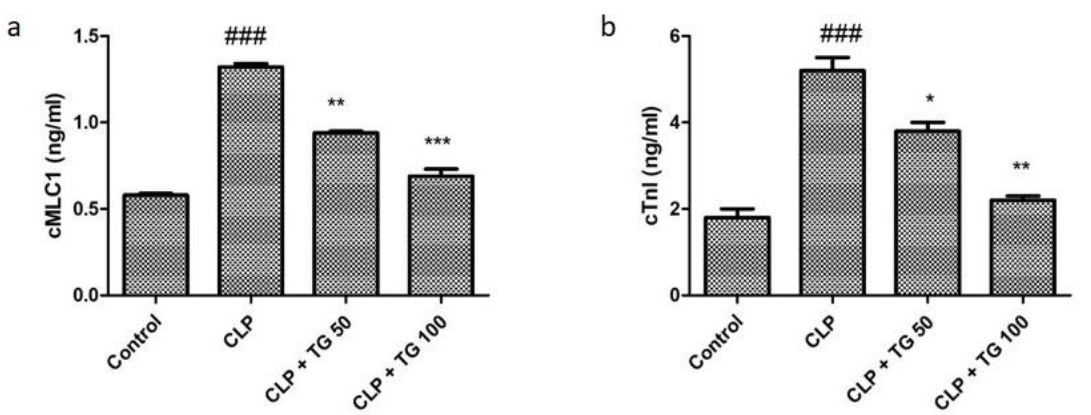
Figure 3. Damage was measured by plasma ( a ) cTnI and ( b ) Cardiac myosin light chain-1 (cMLC1), which were secreted by damaged cardiomyocytes from the heart. Both of them were significantly increased in CLP-rats and were significantly attenuated by TG (50 and 100 mg/kg) treatment, dose-dependently. Values represented as means ± SD; n = 12/group. One-way analysis of variance (ANOVA), followed by Tukey’s test were used for statically analysis (Significance level * p < 0.05). Where, ### p < 0.001 compared to control group, whereas * p < 0.05, ** p < 0.01 and *** p < 0.001 compared CLP group of animals.